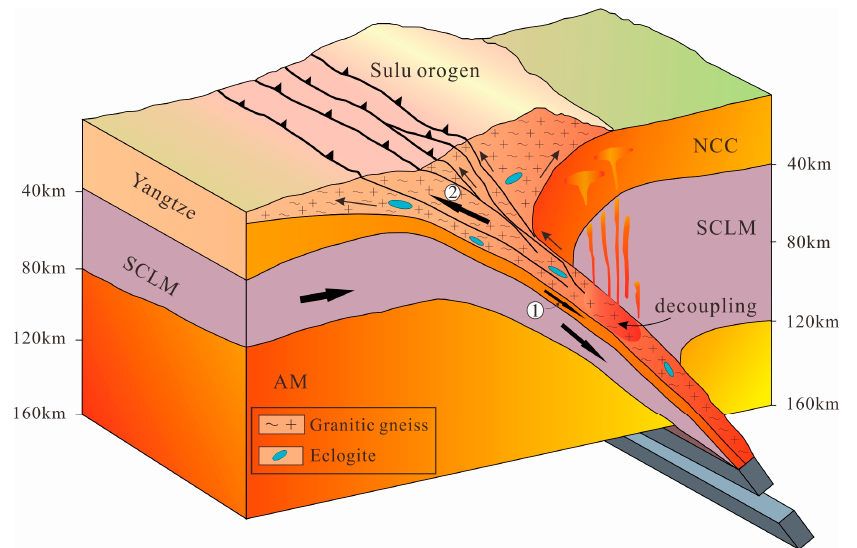
Figure 14. Schematic diagram showing the subduction and decompression process (modified after Wang et al. [69]). Note: NCC = North China Craton; SCLM = subcontinental lithospheric mantle; AM = asthenospheric mantle.